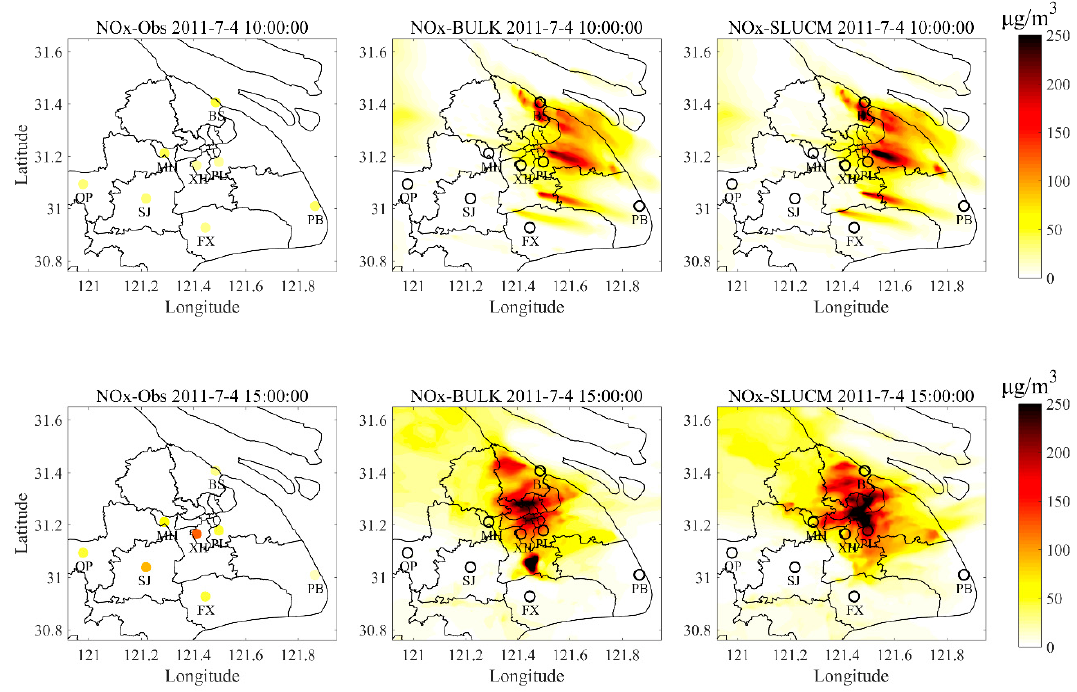
Figure 11. Horizontal distributions of the observed concentration of NO x at eight sites and simulated concentration of NO x field over Shanghai on 4 July 2011 at 10:00 a.m. and 3:00 p.m. BS: Baoshan; MH: Minhang; XH: Xuhui; PL: Pudongliuli; PB: Pudongbinhai; FX: Fengxian; SJ: Songjiang; QP: Qingpu.